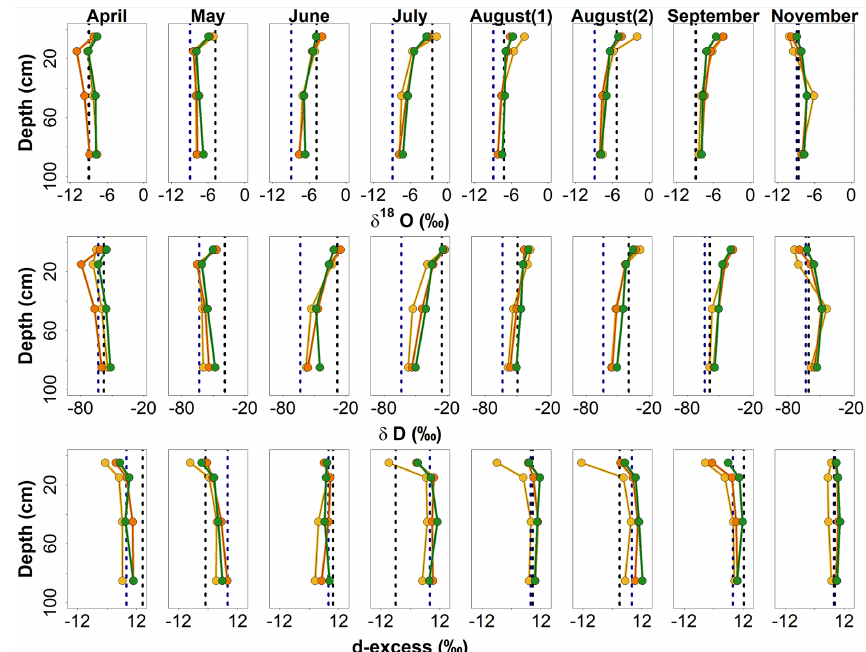
Figure 6. Isotopic depth profiles showing geometric means at different depths at the grassland (yellow), shrub (orange) and tree sites (green) during the monthly sampling campaigns. Dashed lines marking the mean isotopic composition of groundwater (blue) and weighted P mean in the month before or weeks between the sampling campaigns are given for